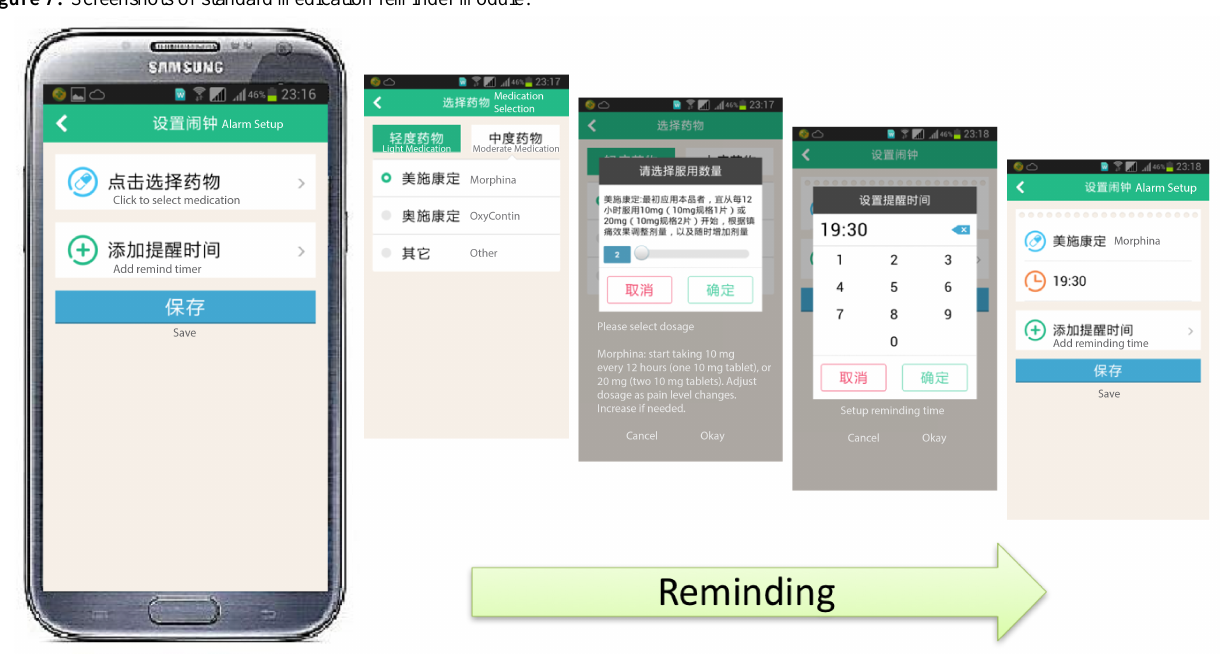
Figure 7. Screenshots of standard medication reminder